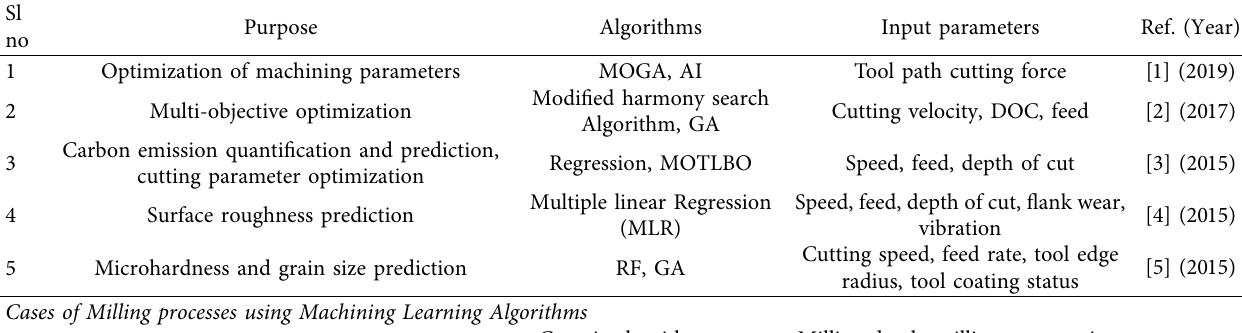
Table 1: Cases of Traditional machining processes using machine learning algorithms.